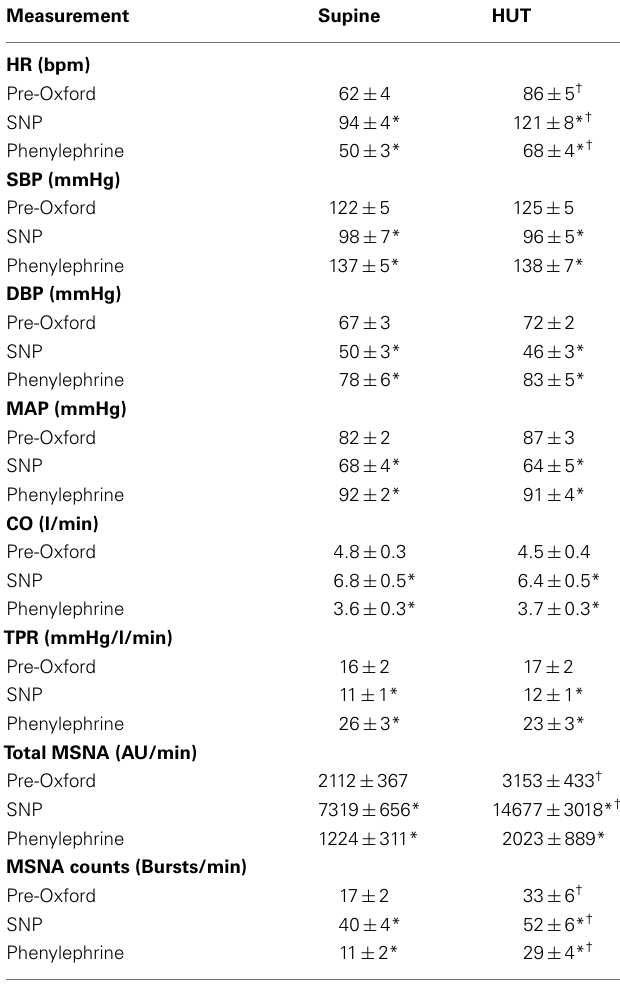
Table 1 | Supine and upright hemodynamics and MSNA pre-Oxford, after SNP bolus, and after phenylephrine.